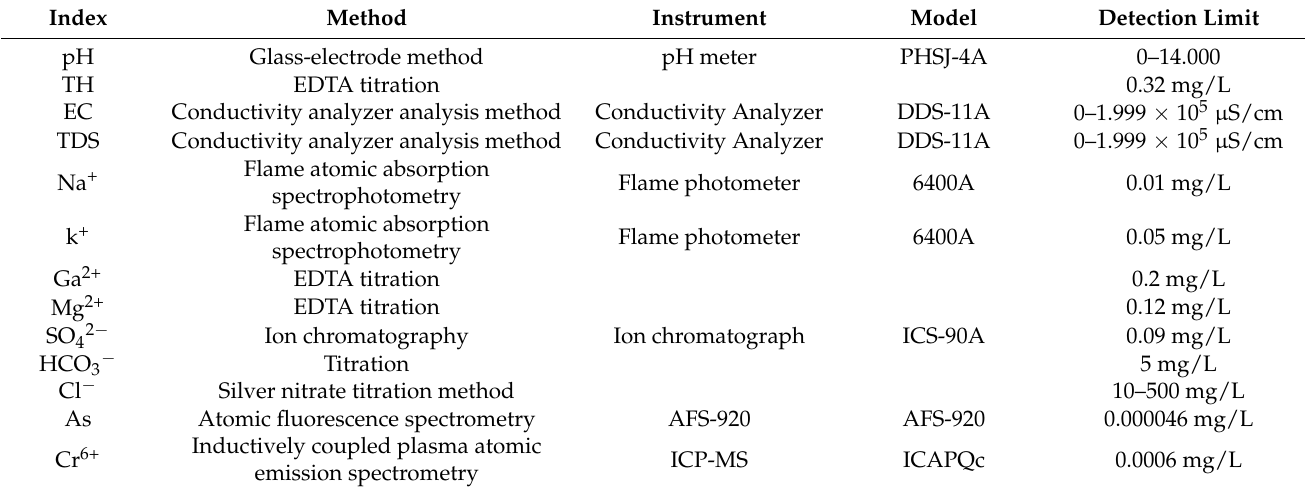
Table 1. Analytical methods, instruments, and detection limits of physiochemical